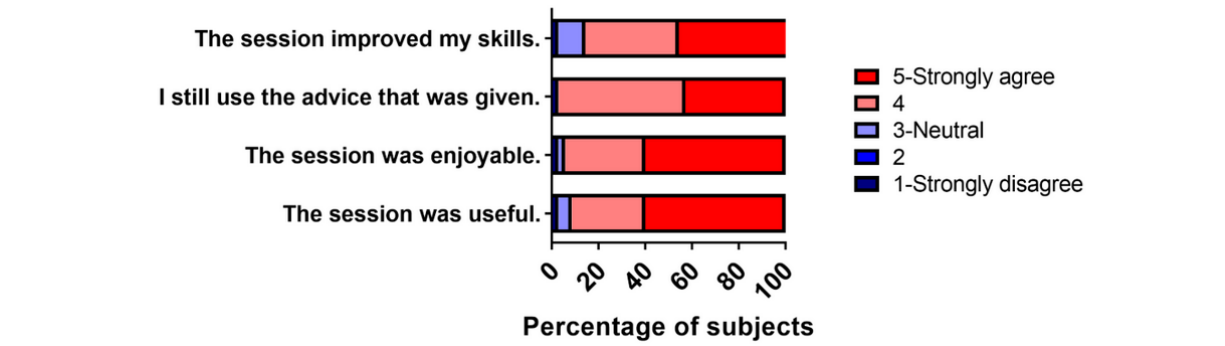
Figure 2. Postactivity satisfaction survey 6 months after the lesson. Intervention interns (n=35, 49%) were surveyed on a 5-point Likert scale for their impression of the simulation-based learning activity 6 months after the session. The graph shows the percentage of participants reporting that the activity was useful and enjoyable, they still use the advice given, and the activity improved their skills. Learners continued to find the activity useful after 6 months of real-world skill